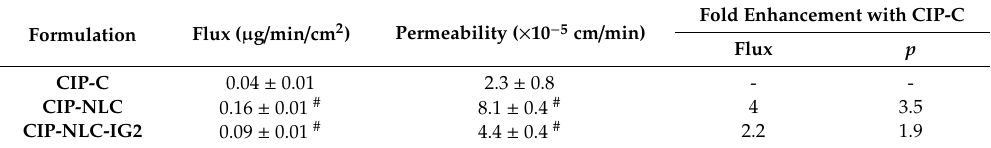
Table 7. Transcorneal flux and permeability of CIP from CIP-NLC, CIP-NLC-IG and CIP-C formulation through isolated rabbit cornea (Mean ± SD, n = 3).